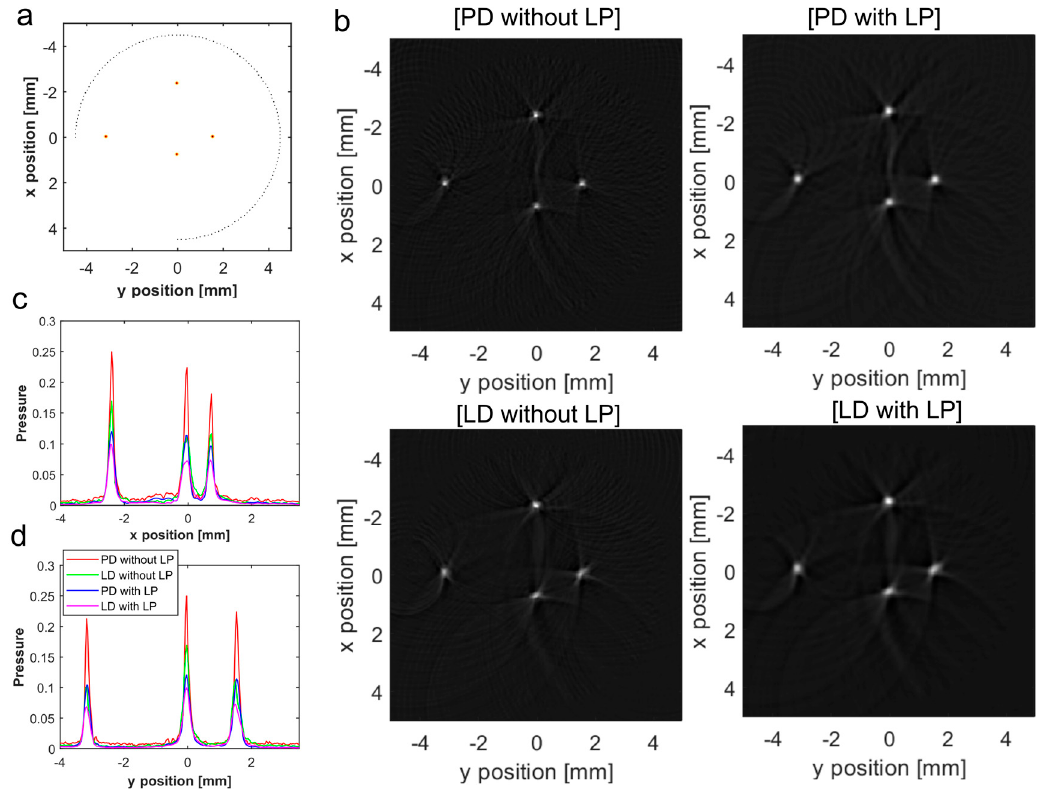
Figure 5. Simulated point spread functions (PSF) of the optoacoustic tomography (OAT) system. ( a ) Distribution of the point sources. ( b ) Reconstructed PSFs under different configurations. PD denotes point detector and LD denotes large detector. LP denotes low pass. ( c , d ) Maximum intensity projections (MIP) along the y -axis and x -axis, respectively.